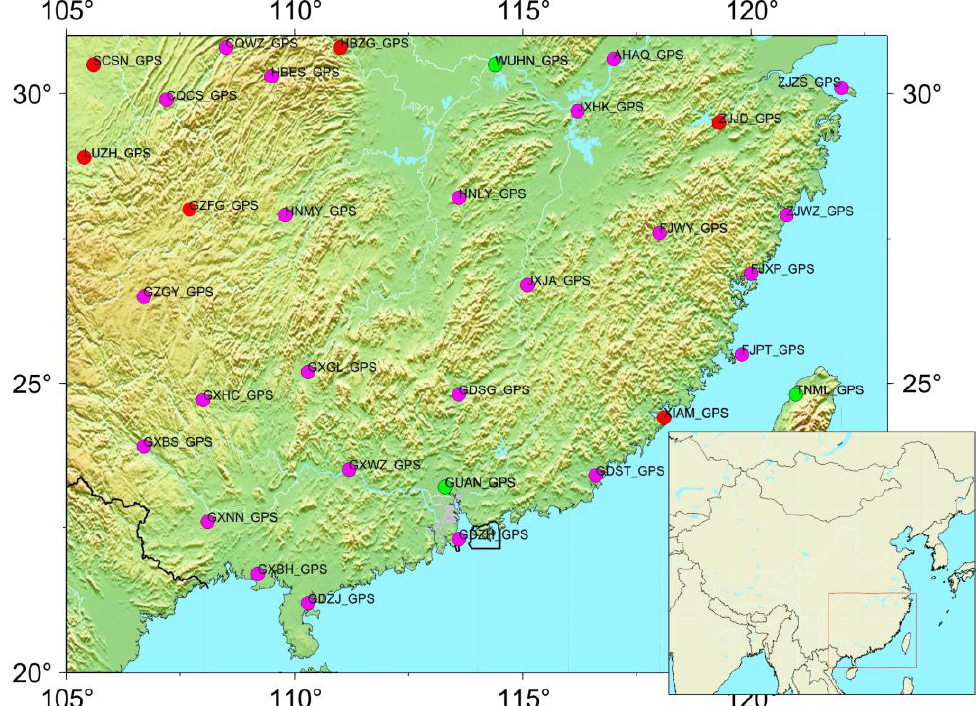
Figure 1. The distribution of GPS stations in and around the South China block (SCB). The magenta circles are the CGPS stations with records spanning from March 2010 to July 2016, and the green dots are the CGPS stations with records spanning from January 1999 to July 2016. The red dots are selected for comparison with GRACE-inferred loading displacement. The map in the inset shows the location of the SCB.